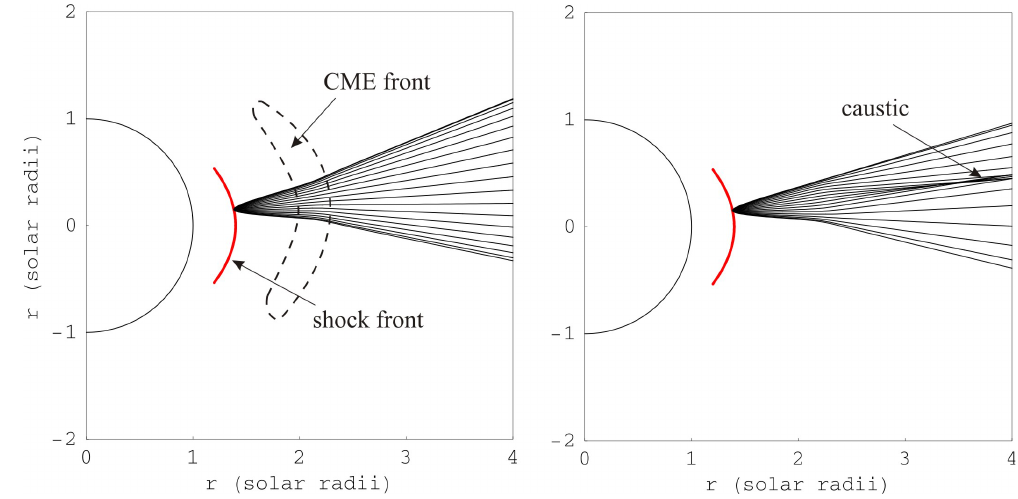
Fig. 2. Characteristic ray trajectory patterns for an individual point source at the shock front. On the left panel, the electron density in the CME frontal structure gradually falls from its central part towards the edges. Therefore, only a broadening of the ray cone occurs. On the right panel, there is a local region with decreased electron density in the CME front, which produces a